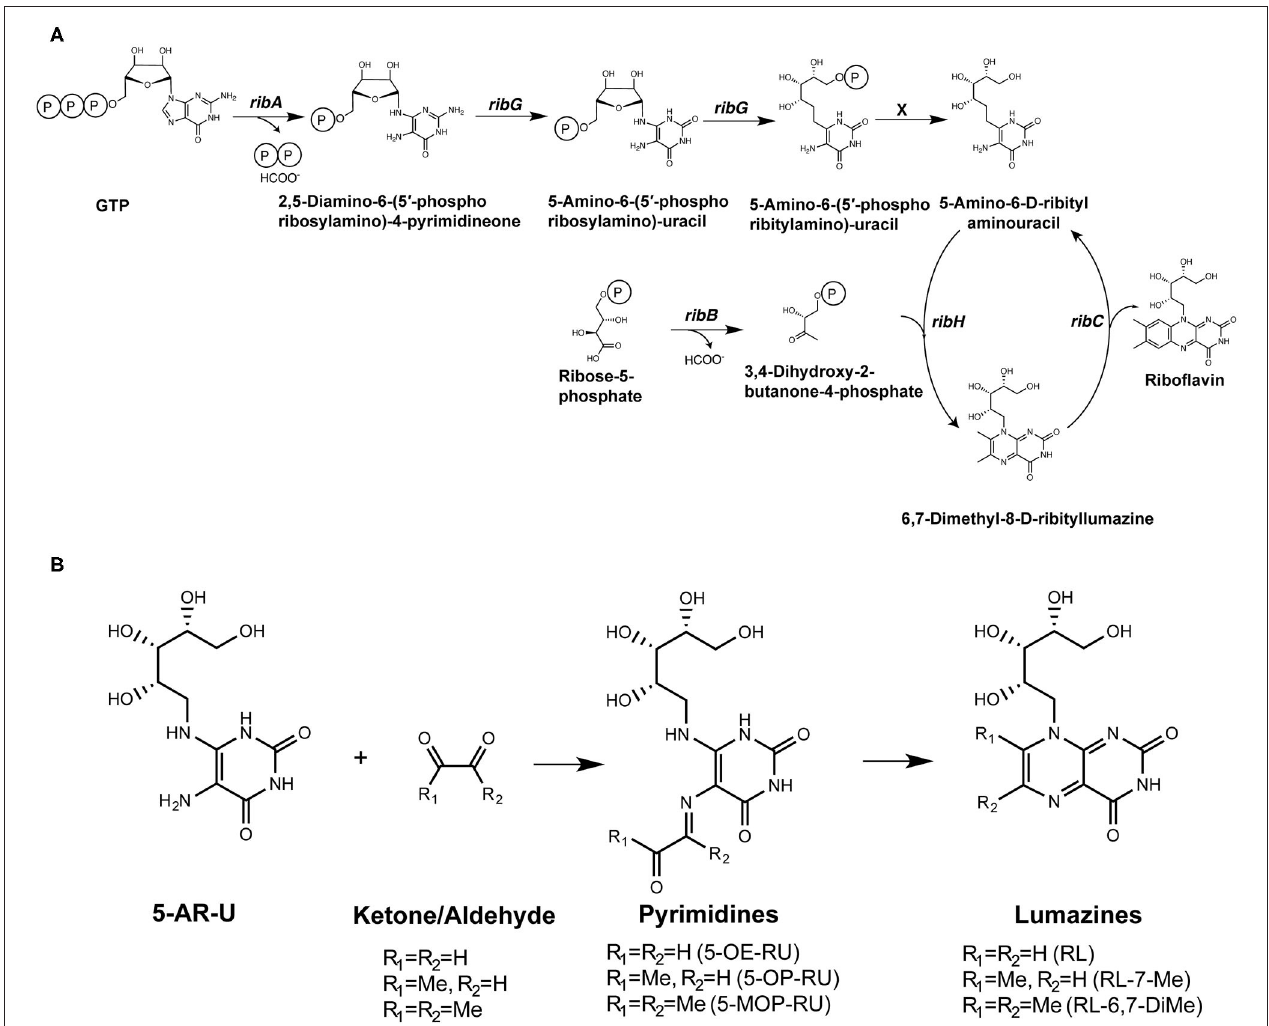
FIGURE 1 | Formation of riboflavin based MAIT antigens. (A) Riboflavin biosynthesis pathway. (B) The riboflavin biosynthesis intermediate 5-A-RU non-enzymatically reacts with small metabolites to form pyrimidine antigens 5-OP-RU and 5-OE-RU. These can be captured by MR1, or alternatively cyclize to form lumazines, some of which are also weakly antigenic [modified from (